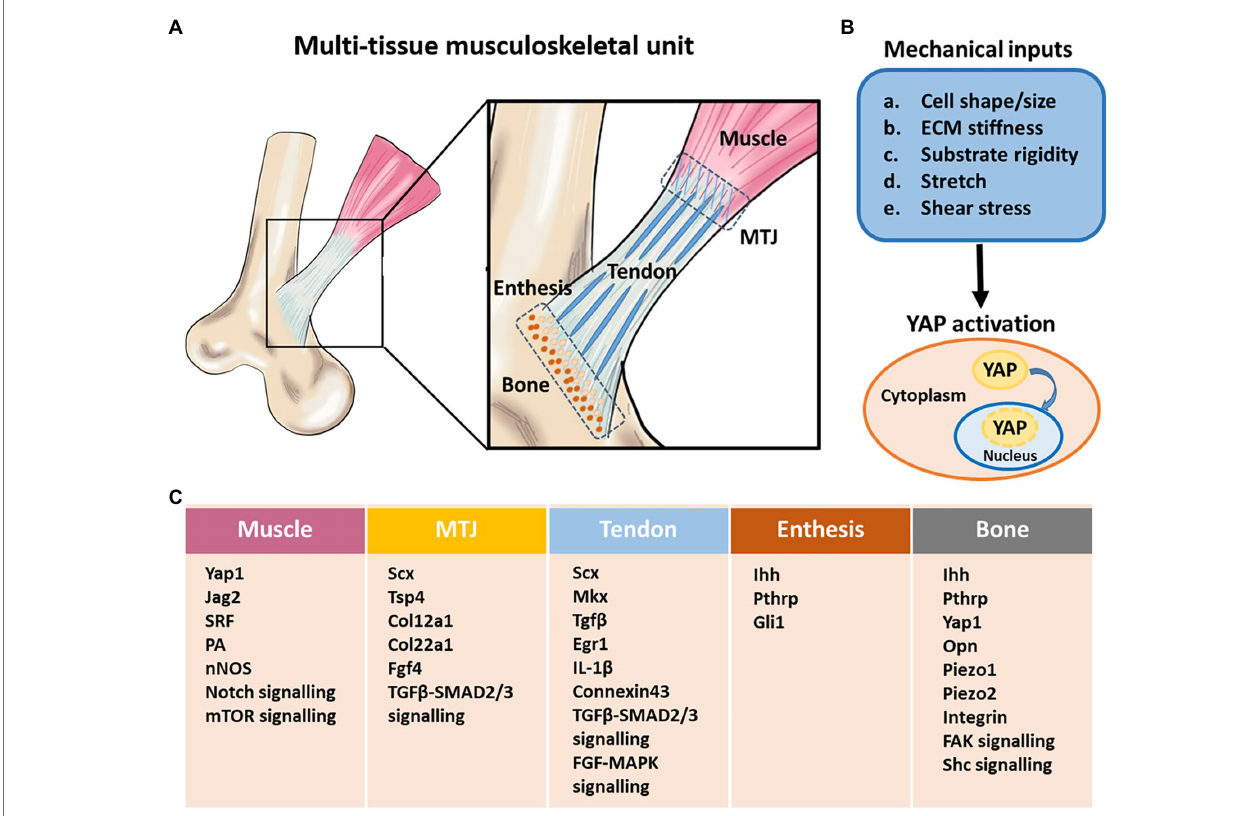
FIGURE 2 | Structural components, and mechanobiological response and gene regulation in the multi-tissue musculoskeletal unit. (A) A schematic illustration of multi-tissue musculoskeletal unit containing bone, tendon, muscle, bone-tendon enthesis, and myotendinous junction (MTJ). The proper formation of tendon, muscle, and the attachment between them requires mechanical load. (B) Different mechanical inputs regulate Yes-associated protein (YAP) activity. YAP is localized to the nucleus and active under mechanical conditions that lead to high intracellular tension. (C) Mechanically regulated key signaling pathways, factors and genes involved in musculoskeletal system development. MTJ, myotendinous junction. Adapted with permission from Felsenthal and Zelzer